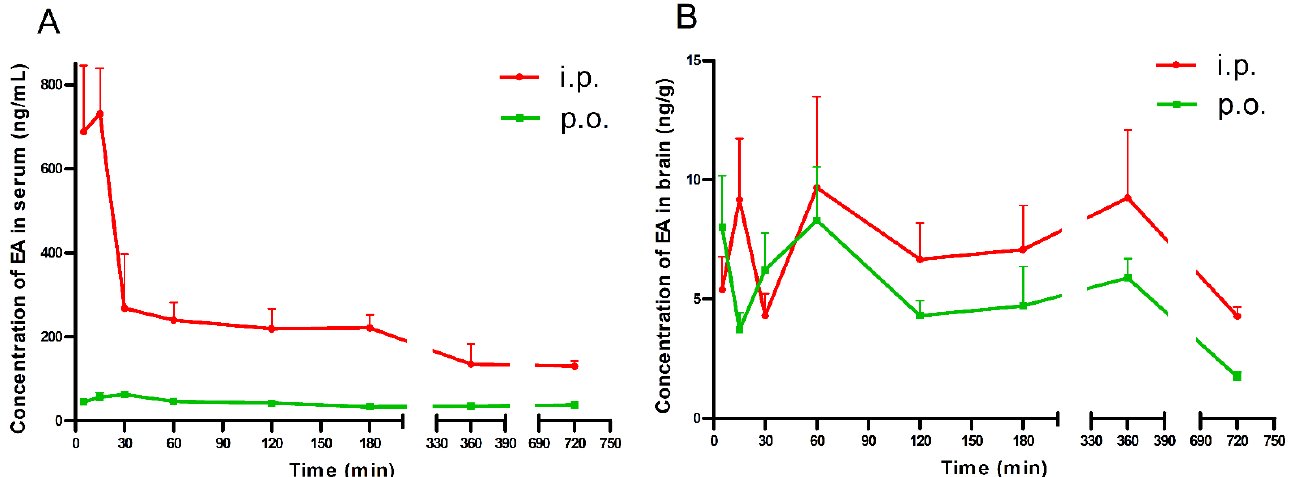
Figure 1. Serum ( A ) and brain ( B ) concentrations of EA in mice. Data are presented as the mean + standard error of the mean (SEM). EA (100 mg/kg) was administrated i.p. or p.o. 5, 15, 30, 60, 120, 180, 360, and 720 min before the mice were decapitated. Experimental groups consisted of 3–5 animals.